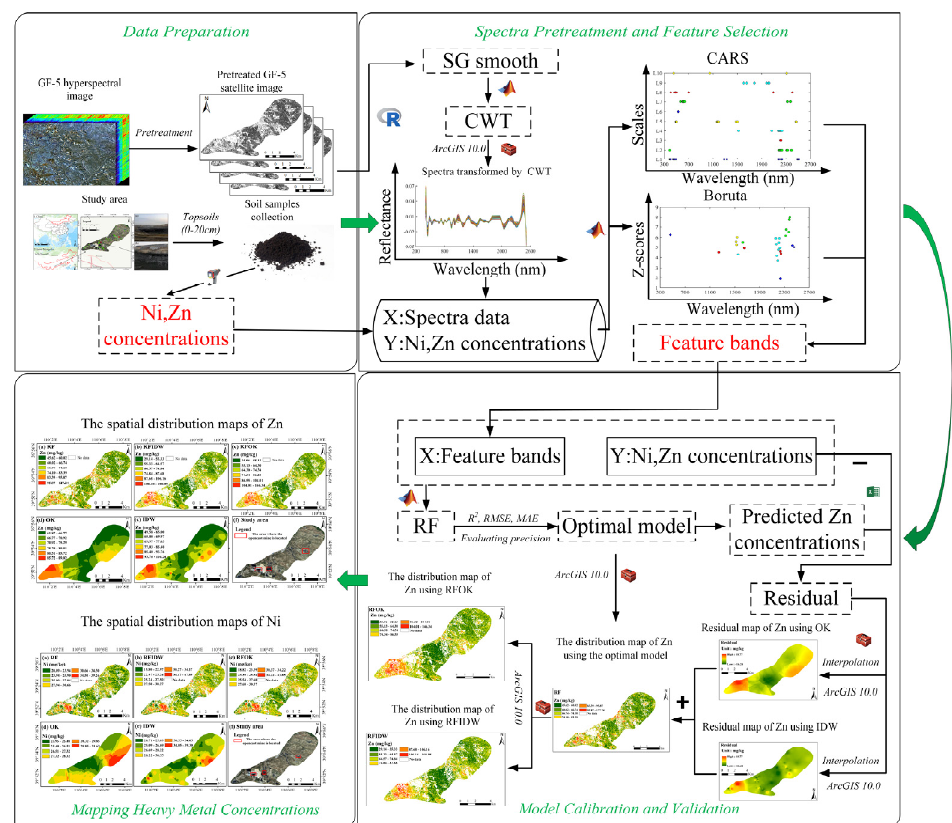
Figure 1. The flowchart of this study.